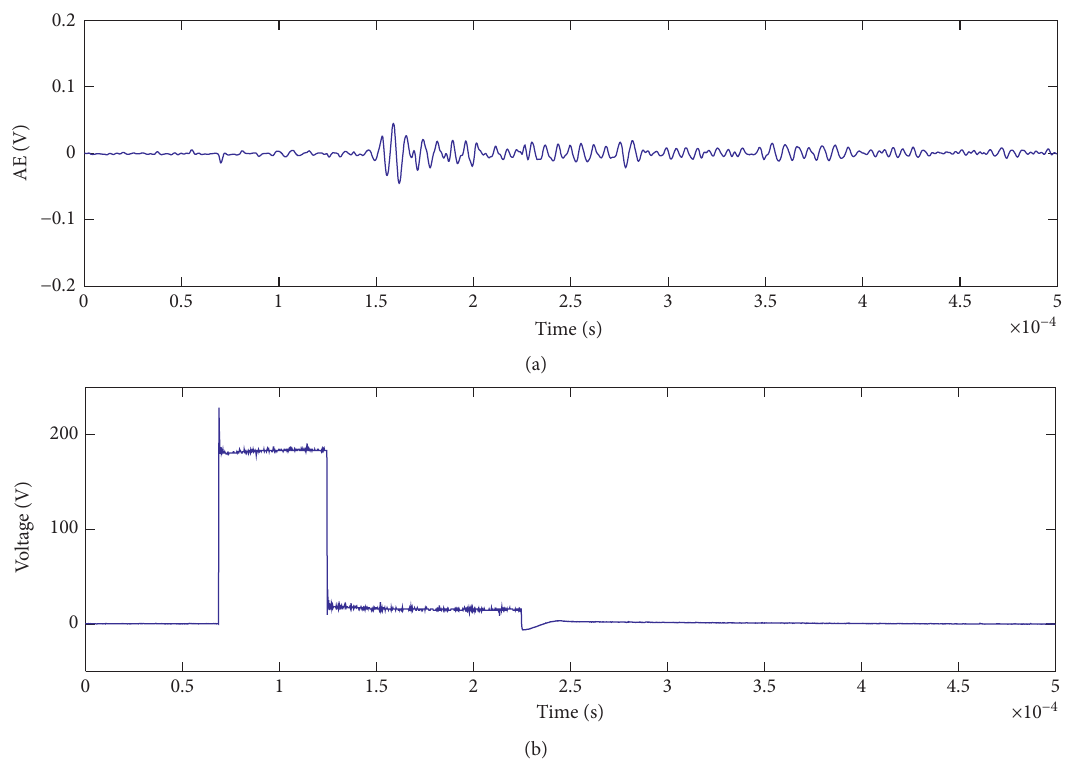
Figure 5: AE wave generated by discharge in air: (a) AE signal and (b) discharge voltage.